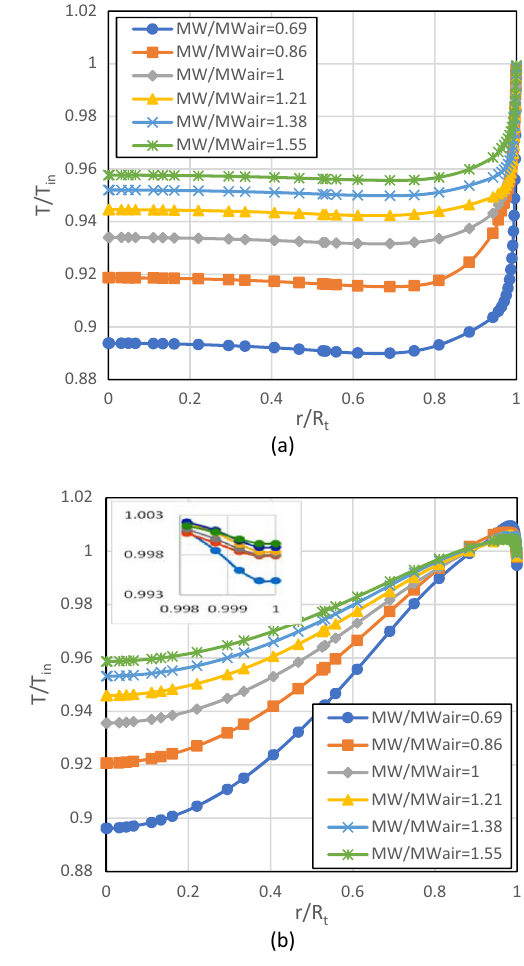
Fig. 11 Dimensionless temperature profiles versus dimensionless radial direction plotted at z∕L = 0.63 for various molecular weight ratios. a ) Static and b total temperatures with 400 kPa at the inlet, 0 kPa at the cold outlet and 30 kPa at the hot outlet